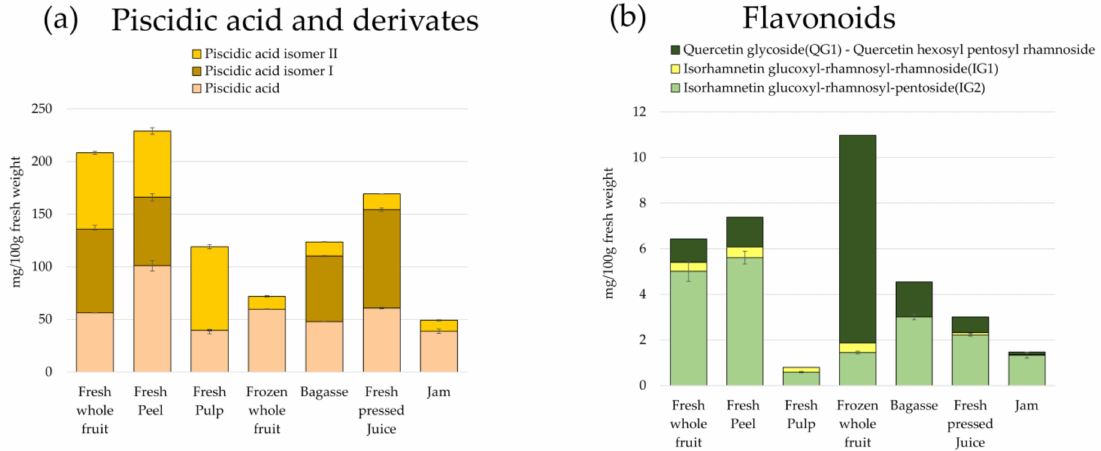
Figure 5. Phenolic compounds content (mg/100 g fresh weight) in Opuntia stricta var. Dillenii fruit tissues (peel, pulp, and whole fruit), jam production products (intermediate juice and jam), and by-product (bagasse) ( a ) phenolic acids: piscidic acid, piscidic acid isomer I, and piscidic acid isomer II; ( b ) flavonoids: quercetin glycoside(QG1)—quercetin hexosyl pentosyl rhamnoside, isorhamnetin glucoxyl-rhamnosyl-rhamnoside(IG1), and isorhamnetin glucoxyl-rhamnosyl-pentoside